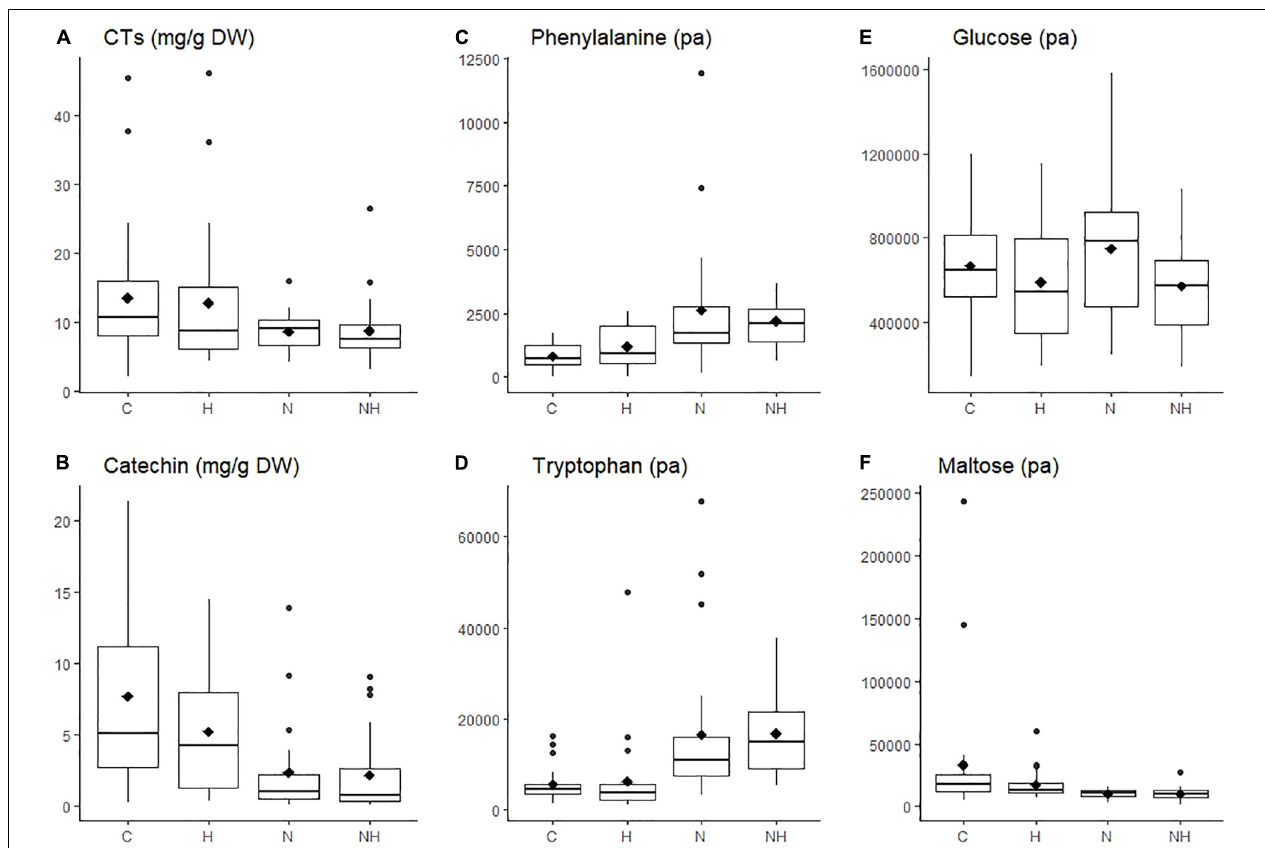
FIGURE 2 | Concentration (mg g − 1 DW) or level (measured as normalized peak area, pa) of individual chemical compounds in the leaves of aspen ( Populus tremula ) plants exposed to environmental endophytic inoculum in controlled, greenhouse conditions: untreated control plants (C) and plants subjected to nitrogen addition (N), herbivory (H), or nitrogen addition and herbivory in combination (NH) ( n = 24 plants per treatment). Shown are selected examples for phenolics ( A,B : concentrations of condensed tannins, CTs, and their precursor catechin), amino acids ( C,D : phenylalanine and tryptophan), and sugars ( E,F : glucose, maltose). The data were acquired using liquid chromatography, except for condensed tannins, which we analyzed using a